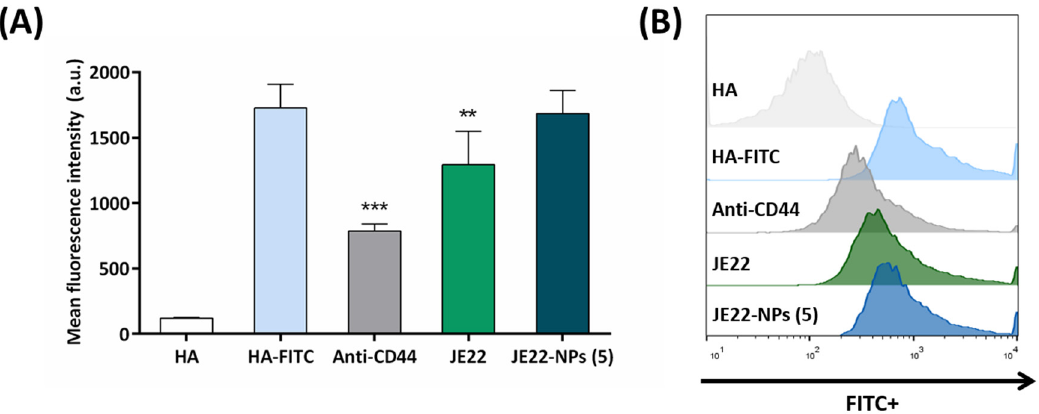
Figure 7. Inhibition of the HA–CD44 interaction by flow cytometry. ( A ) Mean fluorescence of MDA-MB-231 cells analyzed by flow cytometry after treatment for 30 min at 4 °C with JE22-NPs ( 5 ), JE22, and anti-CD44 followed by incubation with HA-FITC for 15 min at 4 °C. Cells treated with unlabeled HA and HA-FITC were used as the negative and positive control, respectively. Error bars: ±SD from n = 3; p < 0.01, **; p < 0.001, *** (ANOVA). ( B ) Flow cytometry overlay histograms of HA-FITC competitive assay binding to MDA-MB-231 cells.